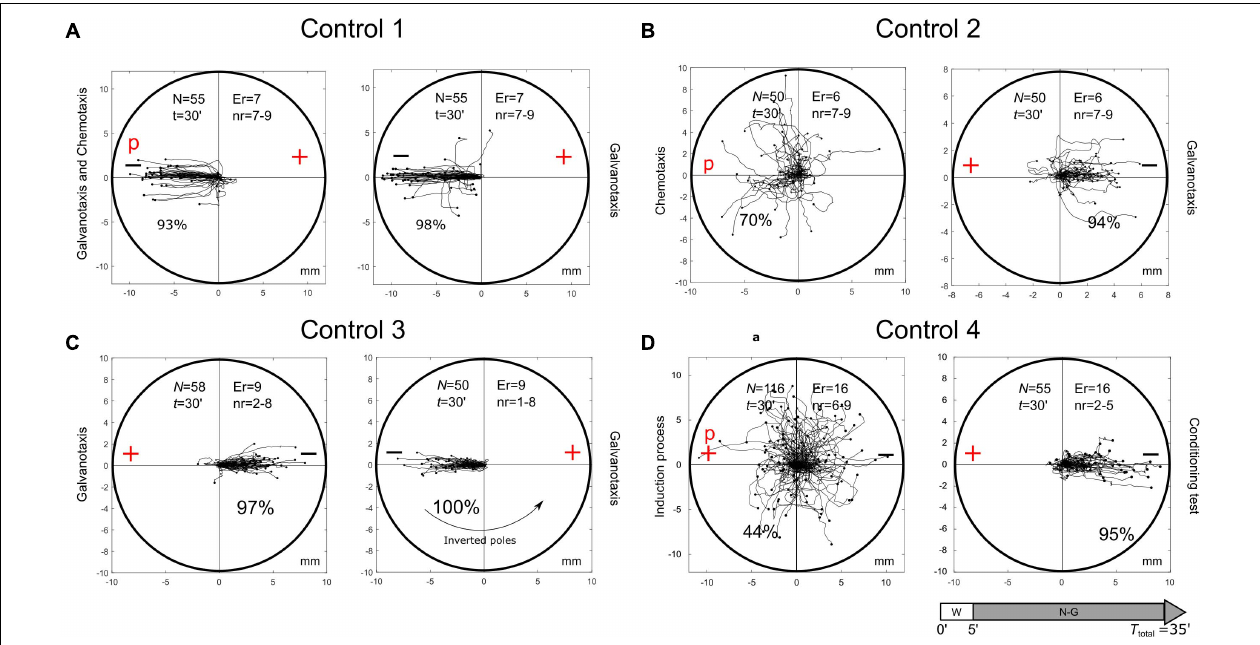
FIGURE 4 | Control tests. (A) Control test on the capacity of nFMLP to change the migration of Amoeba proteus in an electric field. A total of 55 Amoeba proteus were exposed simultaneously to galvanotactic and chemotactic stimuli for 30 min, placing the nFMLP peptide in the cathode. The same 55 amoebae previously exposed simultaneously to galvanotactic and chemotactic stimuli were subjected to a single electric field without peptide for 30 min. In both experiments, no cell showed clear directionality toward the anode. (B) Chemotactic and subsequent galvanotactic control. A total of 50 M. leningradensis were exposed to nFMLP peptide for 30 min, and 72% of them migrated toward the anode. Then, those 50 cells were subjected to a galvanotactic stimulus during 30 min, and 90% of the cells migrated toward the cathode, therefore exhibiting normal galvanotaxis confirming that the exposure to the peptide did not alter the normal galvanotactic response. (C) Galvanotactic control with inverted polarity. A total of 58 M. leningradensis were exposed to a galvanotactic stimulus for 30 min; next, the cells were exposed to another identical electric field with inverted polarity (experimental replicates: 9, number of cells per replicate: 1-8). As it can be observed, practically all the cells showed a normal galvanotactic behavior in both occasions. (D) Induction process and subsequent conditioning test of non-induced cells. A total of 55 M. leningradensis were exposed simultaneously to the electric field and to nFMLP peptide for 30 min, and 44% of them migrated toward the anode. Then, those cells that migrated to cathode (56%) were subjected to a galvanotactic stimulus during 30 min, and 95% of such cells migrated toward the cathode, exhibiting normal galvanotaxis, and confirming that the previous exposure to the peptide did not alter the normal galvanotactic response. “N” is the total number of cells, “Er” is the experimental replicates, “nr” is the number of cells per replicate, “t” galvanotaxis time, “+” anode, “ − ” cathode, “P” nFMLP peptide. Both the x and y -axis show the distance in mm, and the initial location of each cell has been placed at the center of the